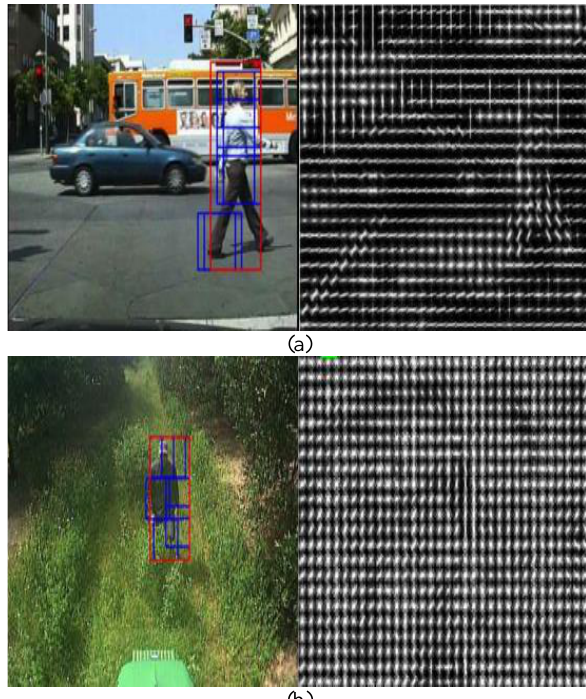
Figure 12. Gradient distribution in city landscape (a) and in off- road landscape